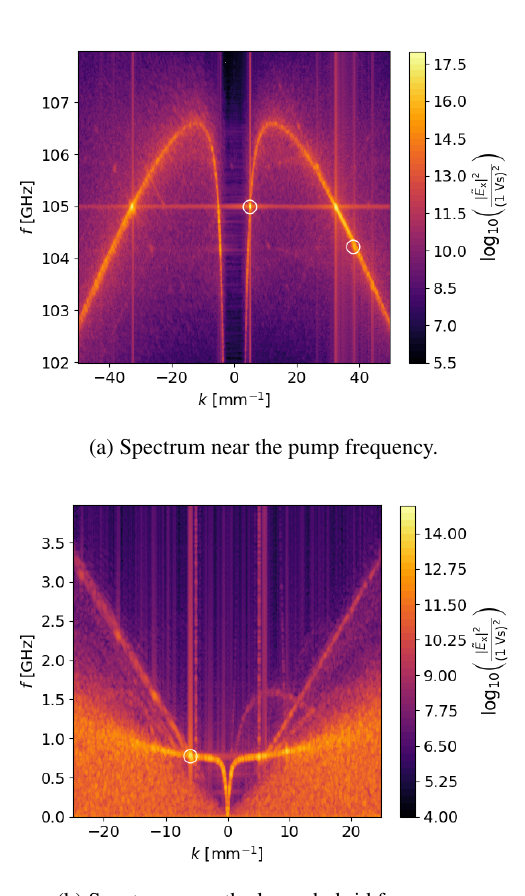
(b) Spectrum near the lower hybrid frequency. Figure 2: 2D fast Fourier transform of E x in t ∈ [10 . 0 , 46 . 7] ns and x ∈ [2 , 4] cm into f- and k-space. The white circles are the expected location for the pump beam (a), the warm UH daughter wave (a) and the warm LH daughter wave